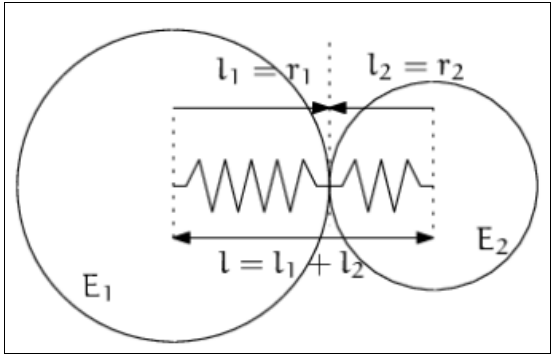
Figure 5. BALL type model in YADE.